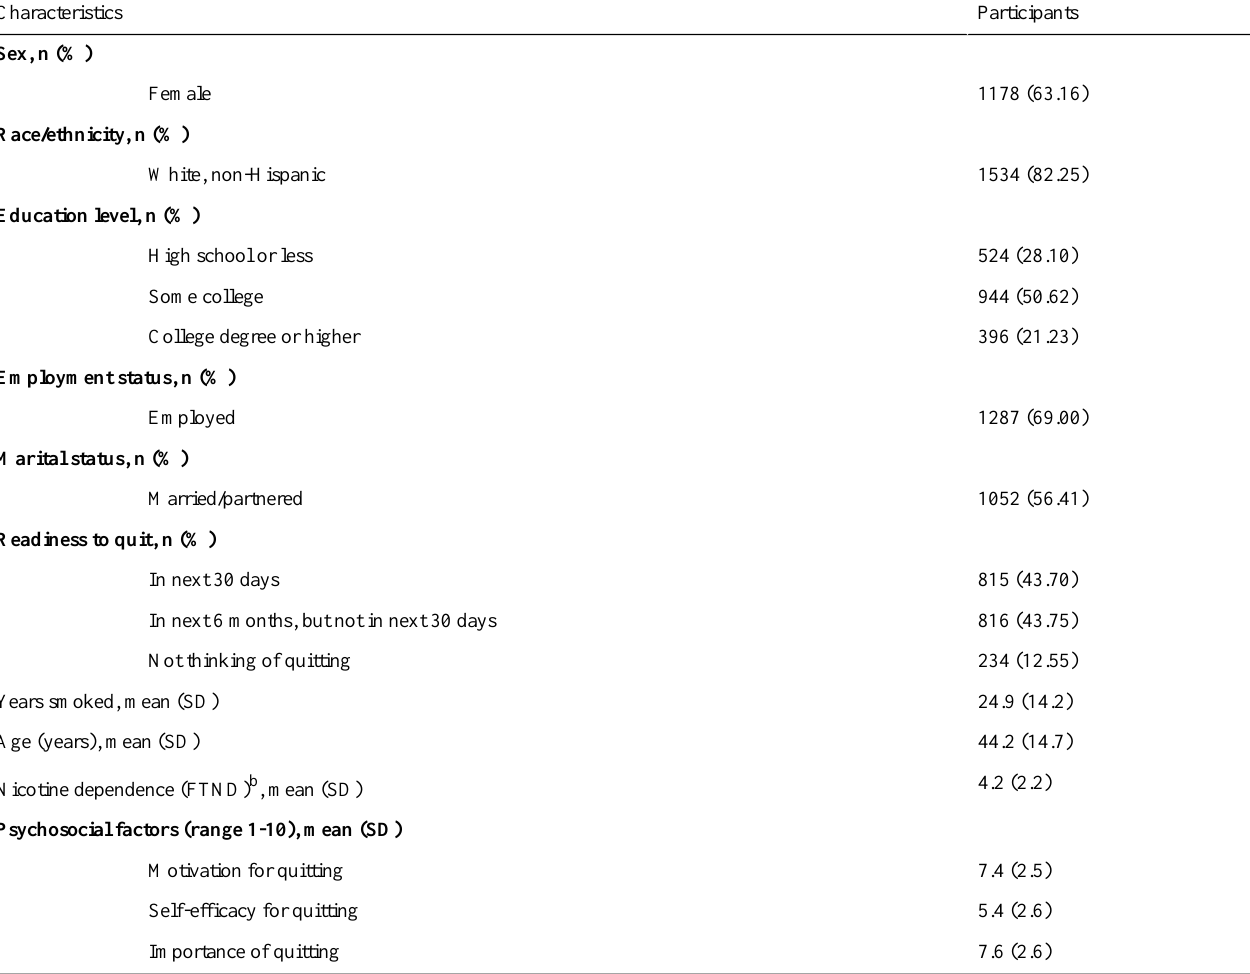
Table 1. Baseline characteristics of enrolled participants a